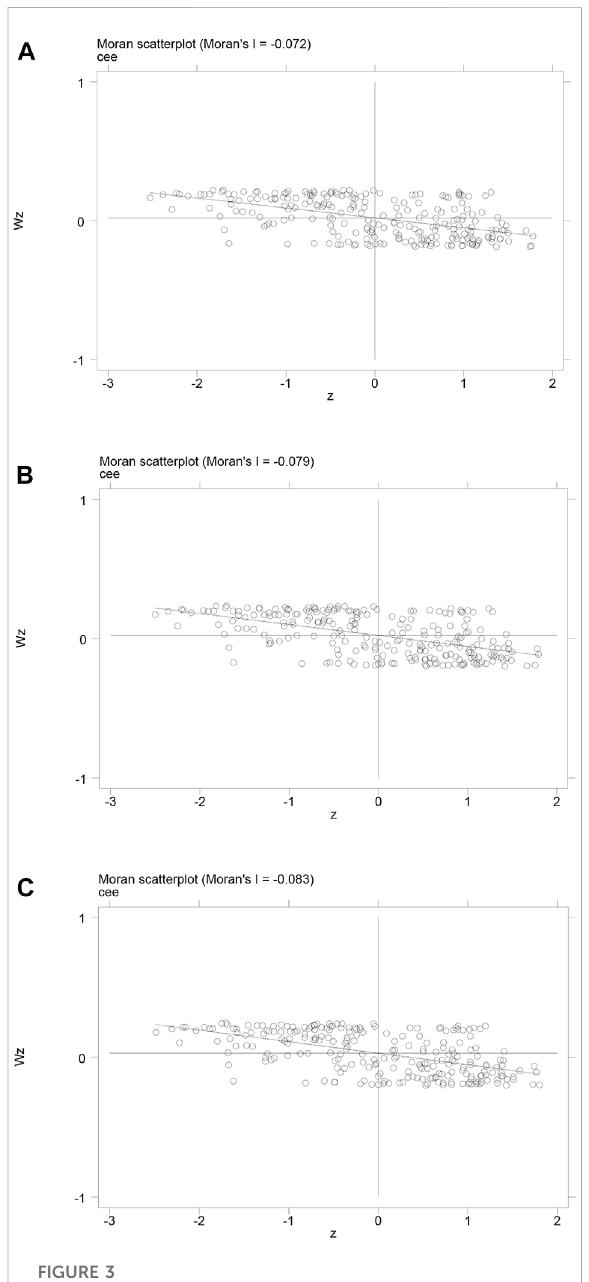
FIGURE 3 Moranscatterplotofurbancarbonemissionperformance. (A) denotes the Moran scatterplot in 2010, (B) denotes the Moran scatterplot in 2010 in 2015, and (C) denotes the Moran scatterplot in 2010 in 2019.